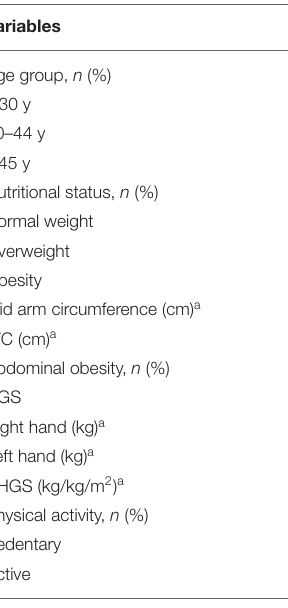
TABLE 1 | General characteristics of the sample.